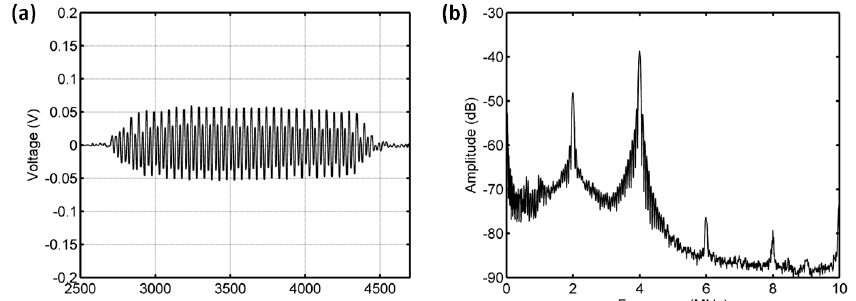
Figure 12. The measured scattering signals from microbubbles and the averaged power spectrum of 50 received signals. ( a ) A single received signal, ( b ) the averaged power spectrum. The driving frequency was 4 MHz, the acoustic pressure was 450 kPa, and the overpressure was 180 mmHg.